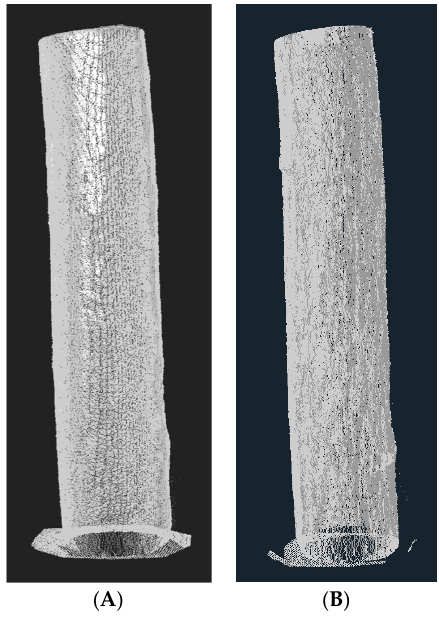
Figure 4. Example of 3D model of the oak tree trunk, ( A ) wrapped in foil; ( B ) natural.